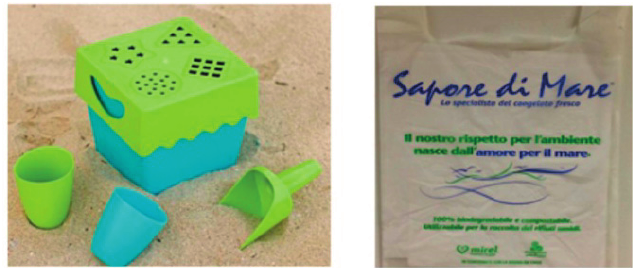
Figure 6. Zoe B Beach Toys, Compostable Shopping Bag, based on Metabolix, Inc.